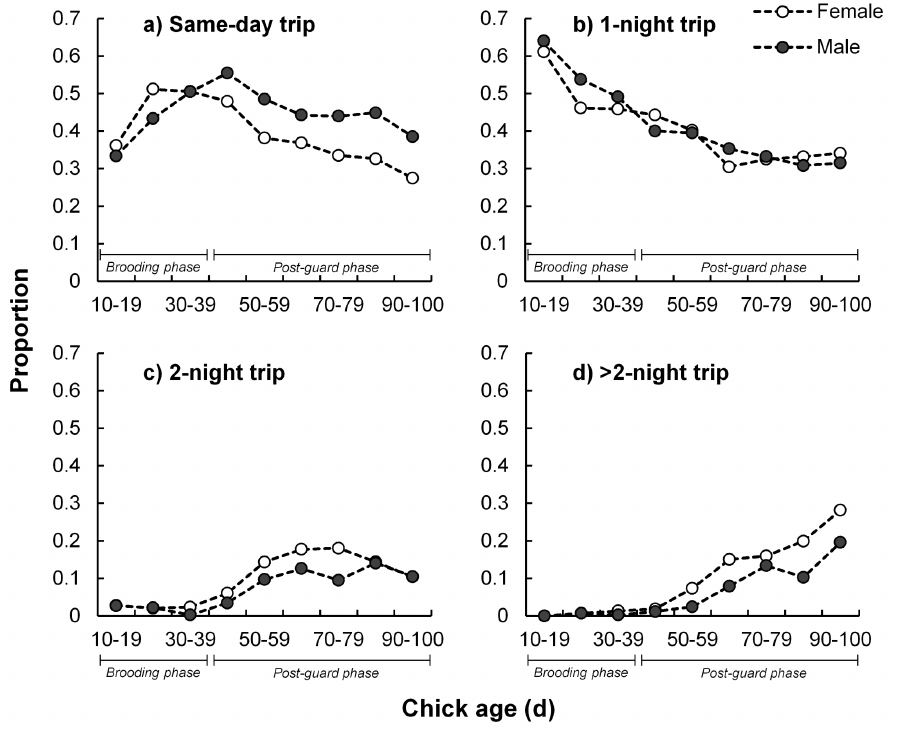
Fig. 2. Sex-specific foraging trip length proportions of adult Cape gannets at Bird Island, Algoa Bay as a function of chick age. Same-day (a), one- (b), two- (c) and greater than two-night (d) foraging trips are indicated for female (white circles) and male (dark circles) birds. Brooding and post-guard phase of chicks are